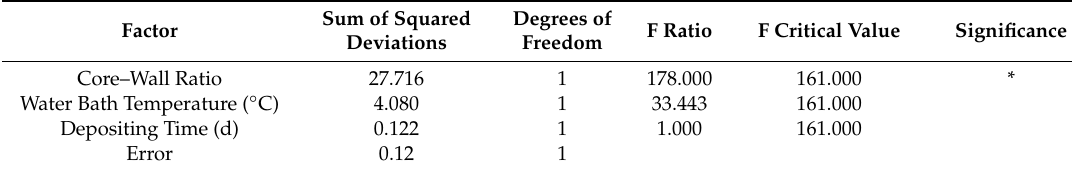
Table 4. Variance results of microcapsule yield.